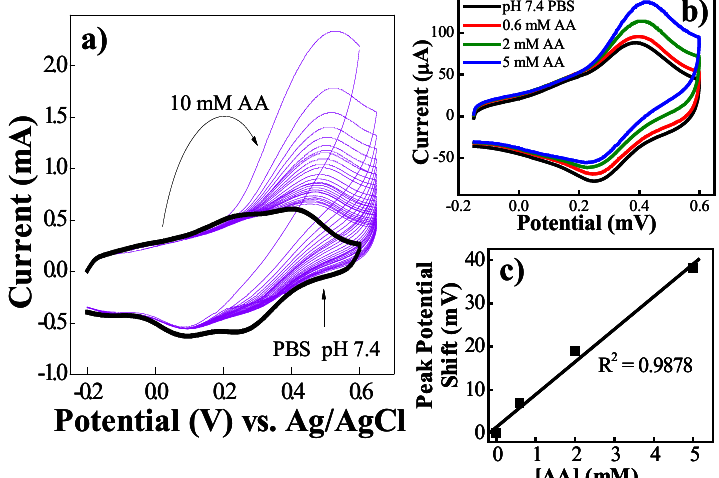
Figure 9. Influence of AA on the PABA/ss-DNA/SWNT composite sensor: a) CVs of the composite in PBS before ( ― ) and after ( ― ) addition of 10 mM ascorbic acid (the first CV upon addition of AA is the tallest one, and each successive cycle yielded a smaller curve); b) titration of the composite with AA ranging from 0.6 mM to 5 mM; c) a graph of the shift in peak potential of the composite’s CV upon addition of AA as a function of the concentration of AA. Potential scan rate: 100 mV  s -1 . (Reproduced with permission from the American Chemical Society